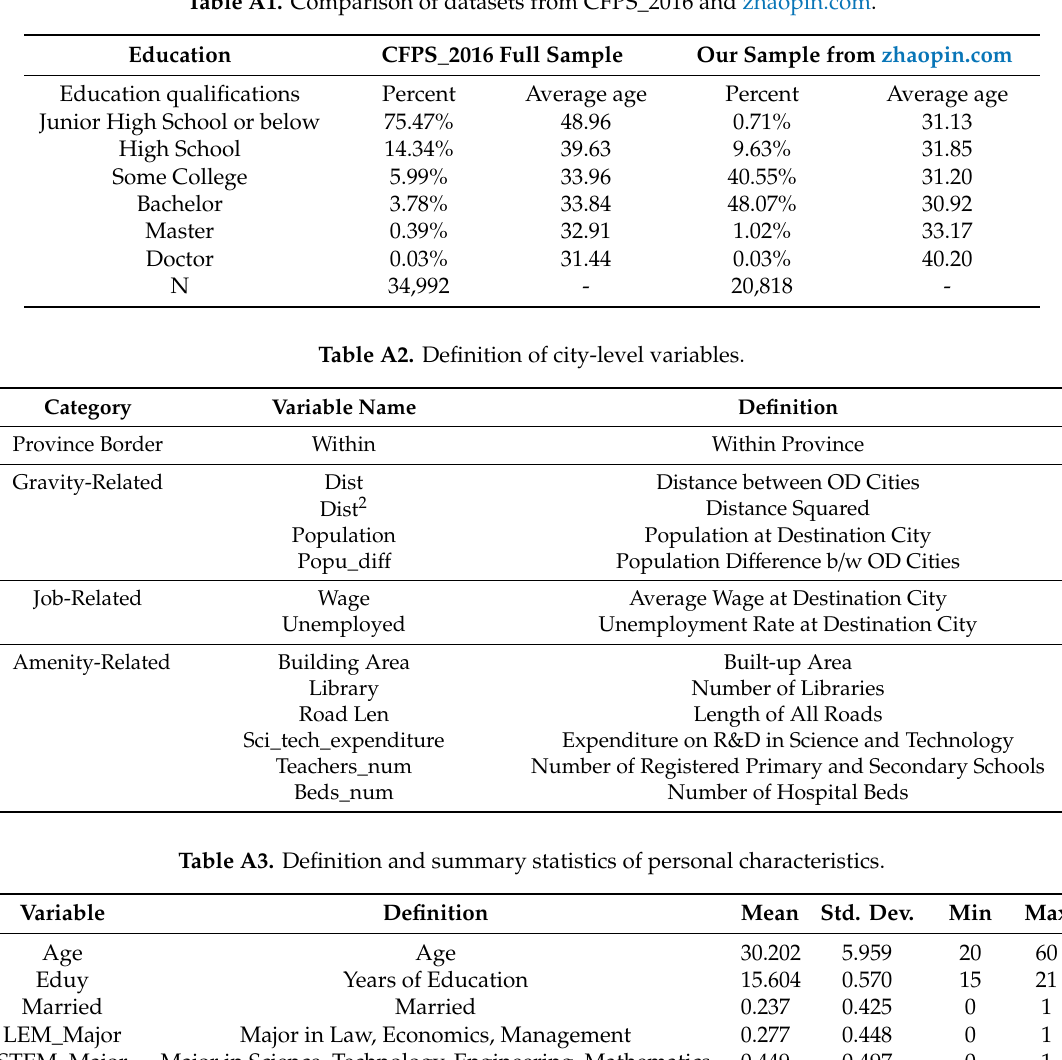
Table A1. Comparison of datasets from CFPS_2016 and zhaopin.com.